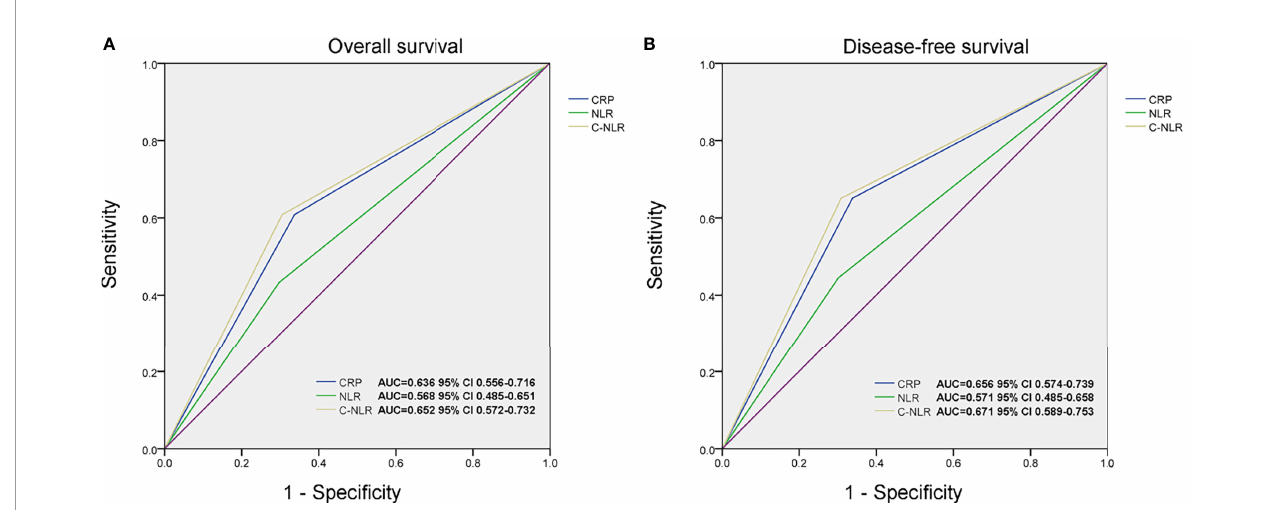
FIGURE 2 | The area under the curves (AUCs) of C-reactive protein (CRP), neutrophil-to-lymphocyte ratio (NLR), and C-NLR in overall survival (OS) (A) and disease- free survival (DFS) (B) prediction after radical cystectomy were compared based on the results of receiver operating characteristic (ROC)